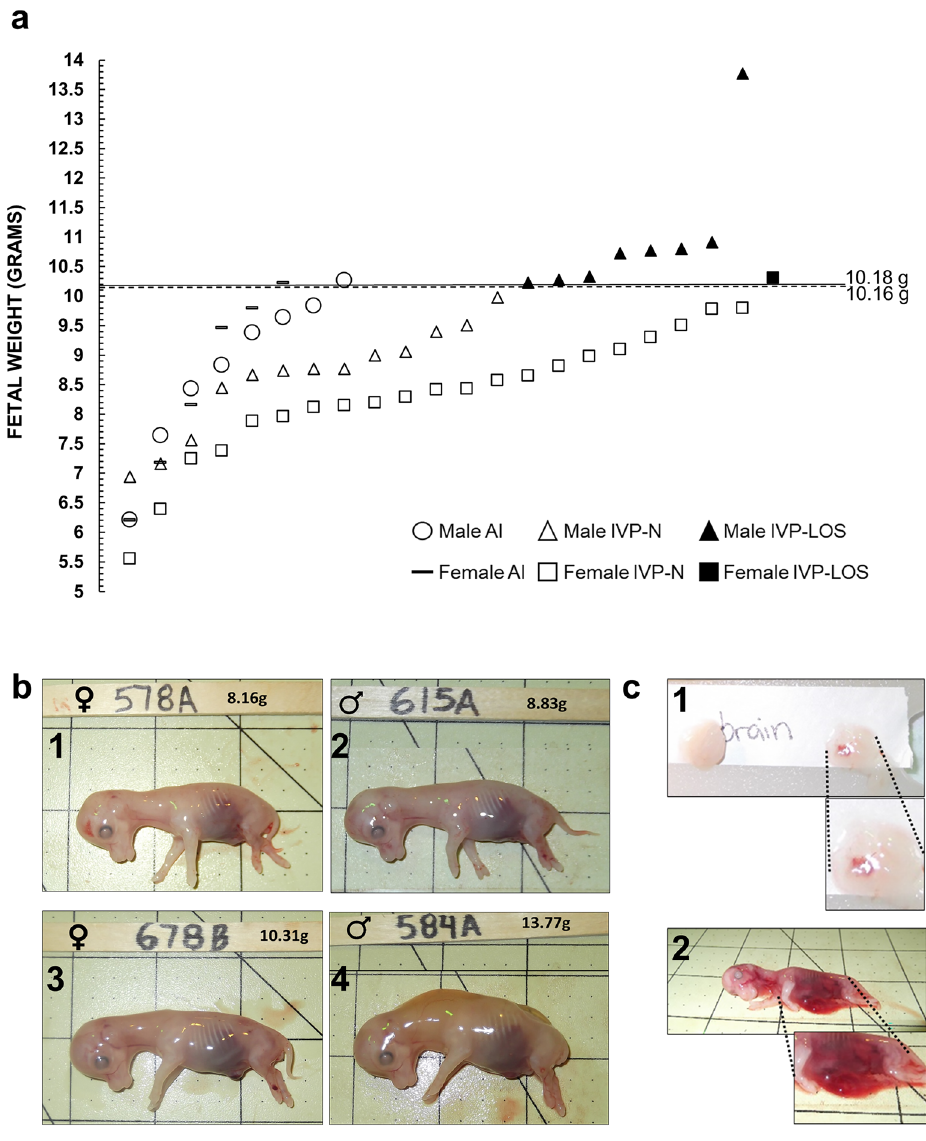
Figure 2. D56 fetal collections. (a) Fetal weight at D56 of gestation. The X axis has no actual implication and is used to scatter the spots representing each fetus for ease of visualization. The sex of the fetuses and the way they were generated is shown at the bottom of the figure. The lines represent the 97 percentile of AI D56 fetal weight (i.e., male—10.18 g, female—10.16 g). (b) The pictures show D56 fetuses in the control (b1,b2) and IVP-LOS group (b3,b4 ). Also, females (b1,b3) and males (b2,b4) . (b1) AI-578A (control female weighing 8.16 g which is approximate average weight of female control fetuses). (b2) AI-615A (control male weighing 8.83 g which is the approximate average weight of male control fetuses). (b3,b4) Show the heaviest LOS (IVP-LOS 678B: female weighing 10.31 g and IVP-LOS 584A: male weighing 13.77 g). Each square on the background = 2.54 cm. (c) Secondary phenotypes observed in D56 LOS fetuses—focal hemorrhage on the brain (c1) and abdominal wall defects (c2) . LOS large offspring syndrome, AI artificial insemination (i.e., control), IVP in vitro produced